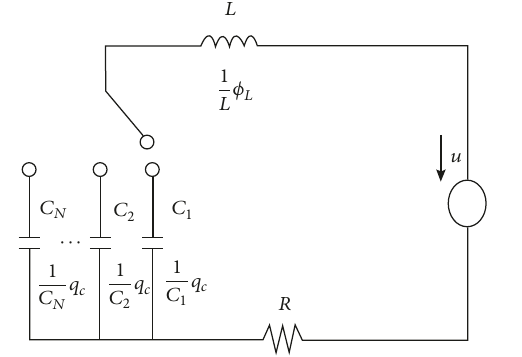
Figure 7: Switched RCL circuit [45].